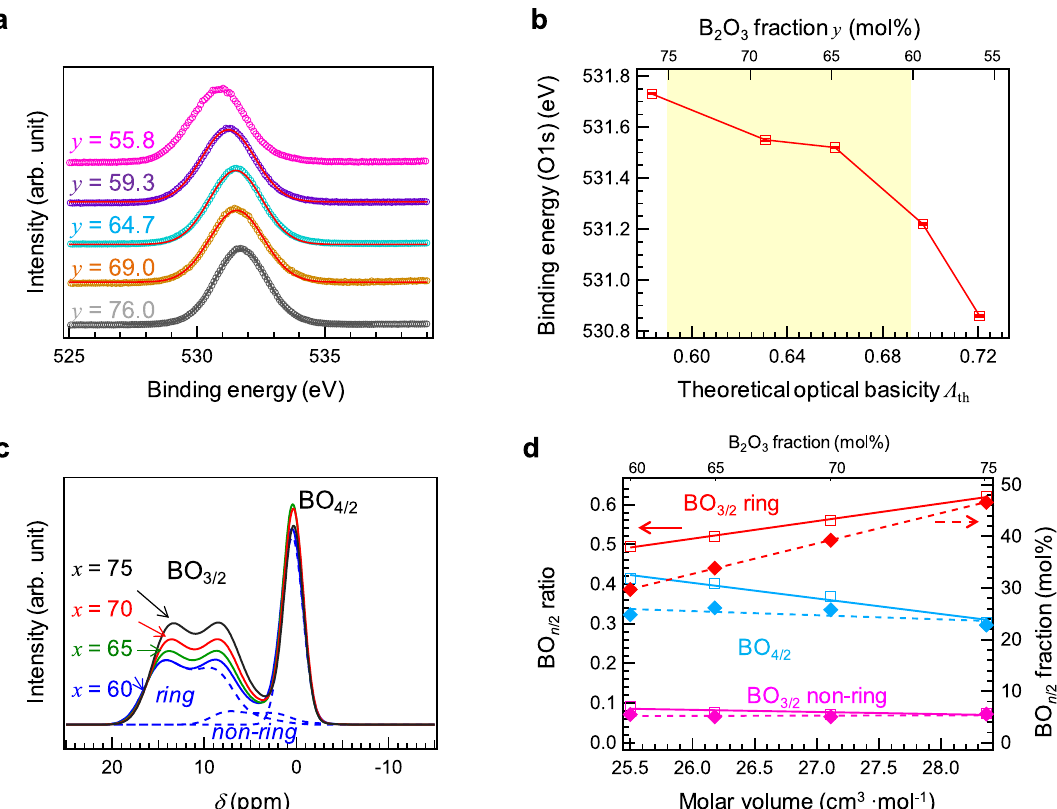
Figure 3. Static structure factors of Ce:SBO x glasses. ( a ) O 1s XPS spectra of (100– y )SrO– y B 2 O 3 glasses 37 . ( b ) O 1s binding energy of (100– y )SrO– y B 2 O 3 glasses as a function of theoretical optical basicity 37 . The coloured region indicates the present glass compositions. ( c ) 11 B MAS NMR spectra of Ce:SBO x glasses. The dashed lines indicate ring BO 3/2 , non-ring BO 3/2 , and BO 4/2 after peak deconvolution. ( d ) Ring BO 3/2 , non-ring BO 3/2 , and BO 4/2 ratio and their fractions as a function of B 2 O 3 fraction. The BO n /2 fractions were calculated from the B 2 O 3 fraction and BO n /2